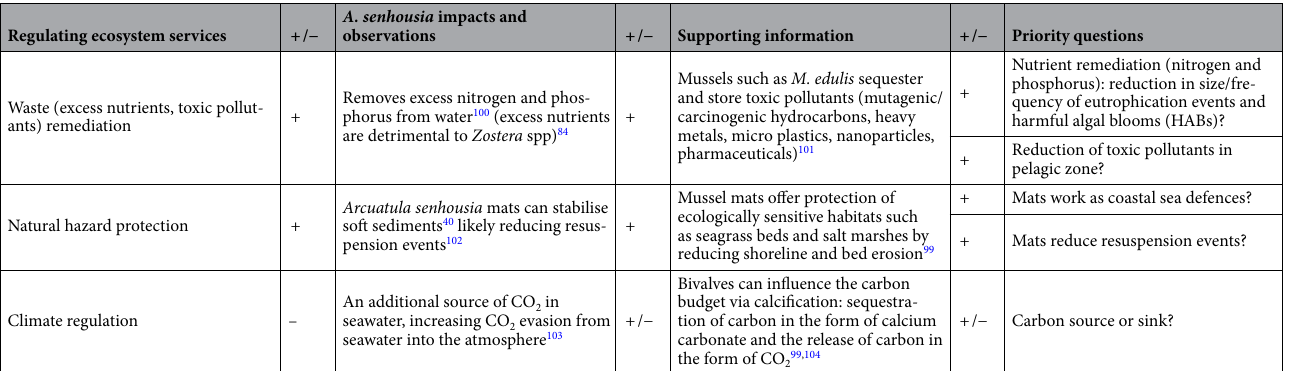
Table 3. A summary of the impacts of A. senhousia in relation to Regulating ecosystem services. ( +) denotes a potentially positive impact, (–) denotes a potentially negative impact. Priority questions are those that should be addressed by researchers to generate a full risk assessment and management